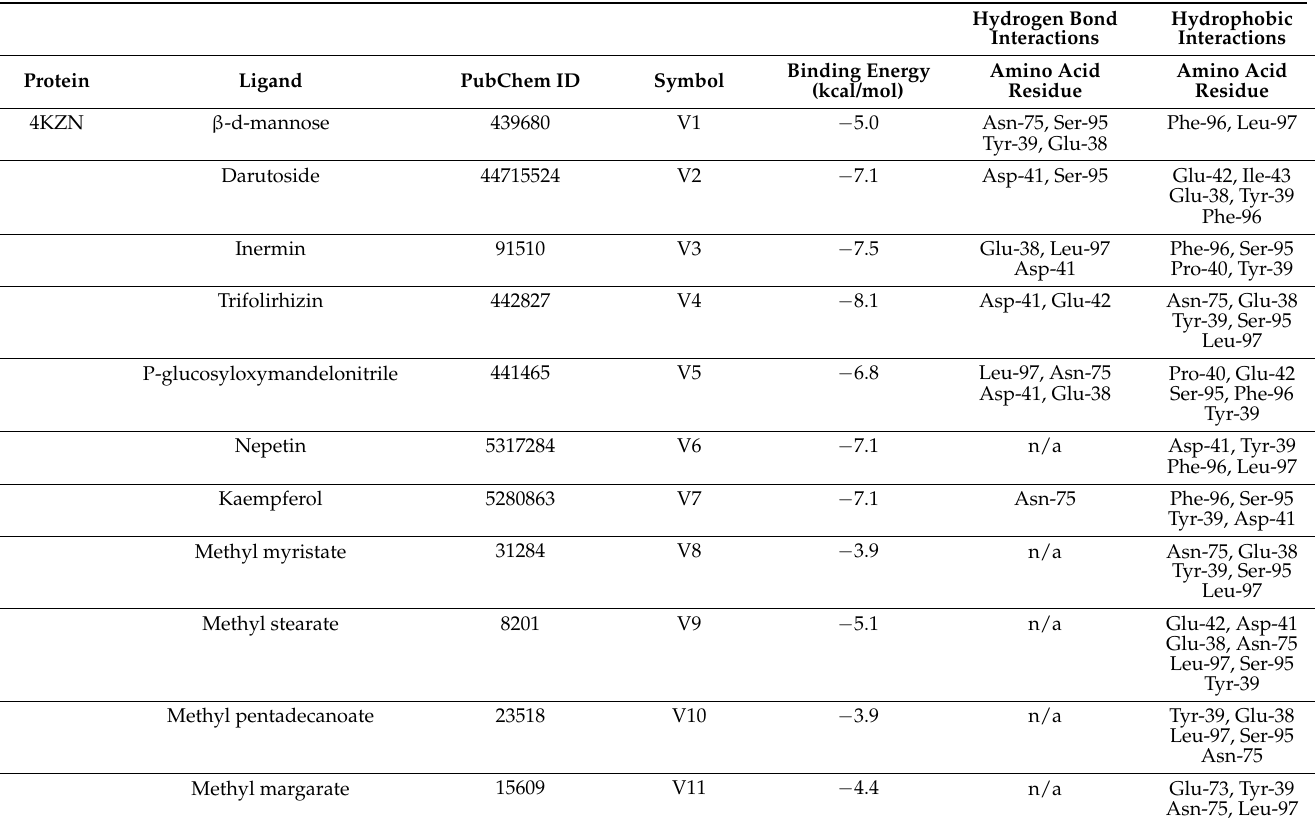
Table 7. Binding energy of potential active compounds on VEGFA (PDB ID: